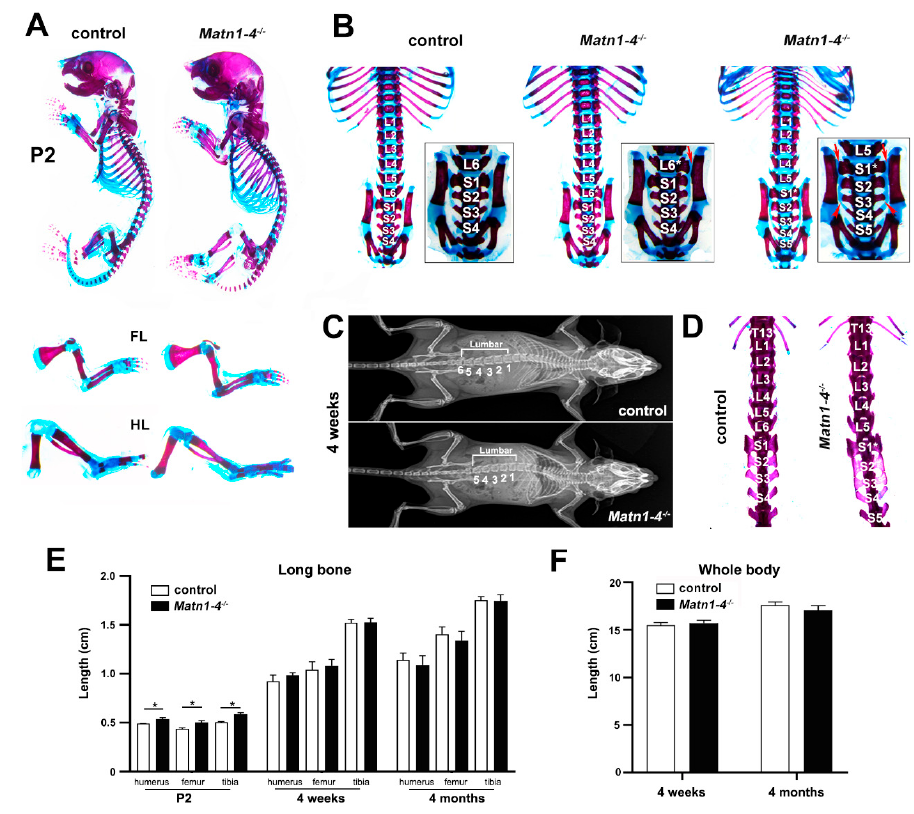
Figure 2. Skeletal phenotype in mice lacking all matrilins. ( A ) Skeletal staining at P2 showed normal formation of the elements of the appendicular skeleton. ( B – D ) Skeletal staining and X-ray analyses at P2 and 4 weeks of age revealed a highly penetrant homeotic transformation at the lumbar-sacral border of the axial skeleton. ( B ) Wild-type (control) mice have 6 lumbar (L1 to L6) and 4 sacral (S1 to S4) vertebrae, S1 articulates to the ilium and S1-S2-S3 are fused. In Matn1-4 − / − mice, L6 is sacralized (S1*) resulting in 5 lumbar (L1 to L5) and 5 sacral vertebrae (S1 to S5). In the mutants, the sacralized L6 vertebra (S1*) gained the typical S1 wing shape (red arrows on B), S1* and S2 are articulate to the ilium and S1*/S2/S3/S4 are fused. The arrowheads depict the fusion between S3 and S4. The heterozygous o ff spring exhibit an intermediate pattern with only one side of L6 is sacralized (L6*) by gaining a wing-shaped transverse process and articulating to the ileum (L6*, red arrow), while the other side retained the lumbar identity. ( C ) Representative X-ray images of wild-type and Matn1-4 − / − mice at 4 weeks. ( D ) Skeletal preparations at 4 weeks demonstrate the sacralization of L6 in the quadruple KO mice. ( E ) Measurements of the lengths of the appendicular skeletal elements indicate a moderate but significantly increased size of mutant long bones at P2. At 4 weeks and 4 months, there is no significant di ff erence between the genotypes. Statistical significance calculated by Mann-Whitney U test where * p < 0.05. ( F ) Comparable body length of wild-type and Matn1-4 − / − animals at 4 weeks and 4 months of age. Abbreviations: FL-forelimb;